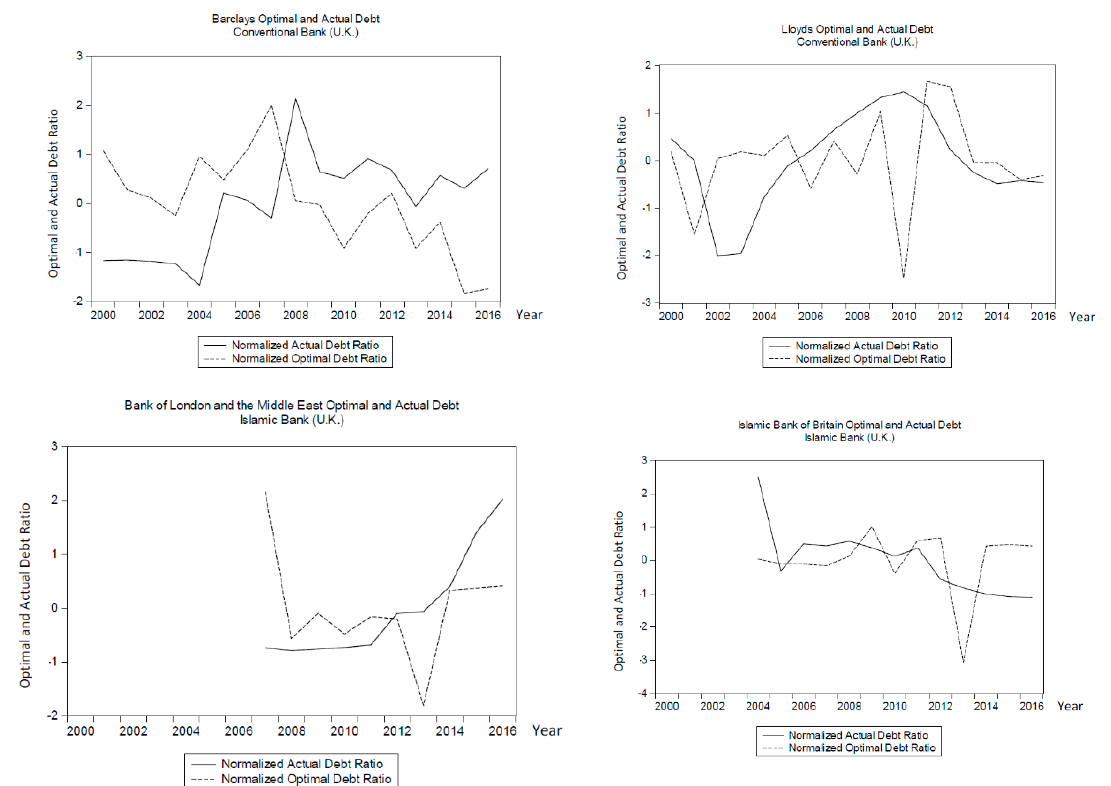
Figure 5. United Kingdom optimal- versus actual-debt ratio. Source: Author’s calculations.